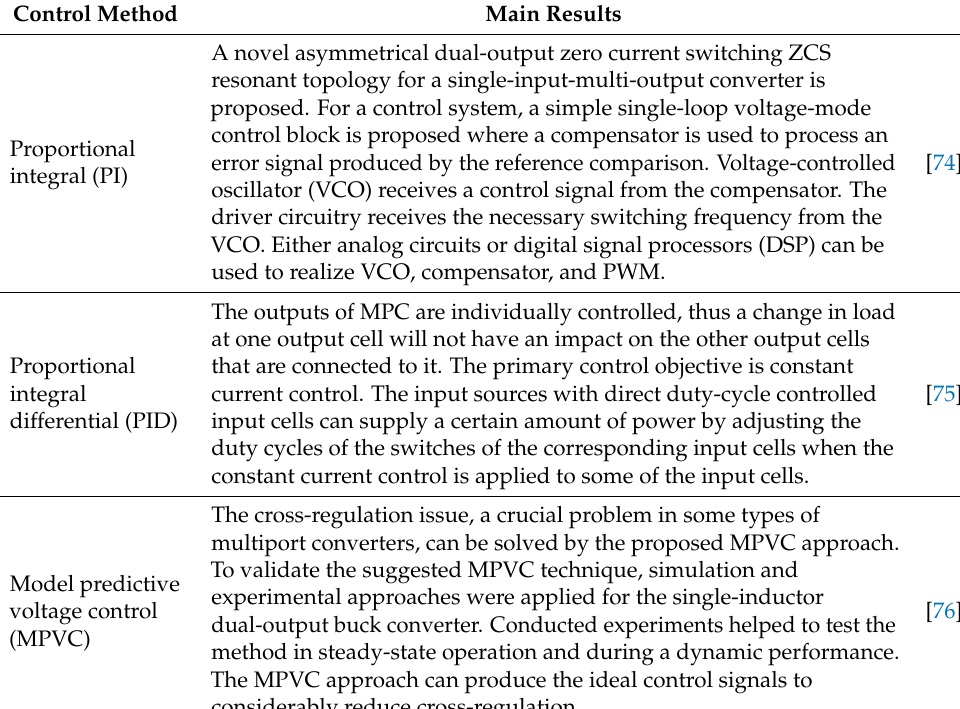
Table 5. Application of different control methods for